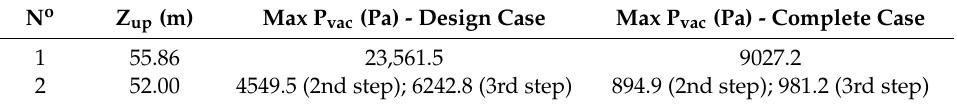
Table 5. Maximum numerical vacumn pressure on step segment.